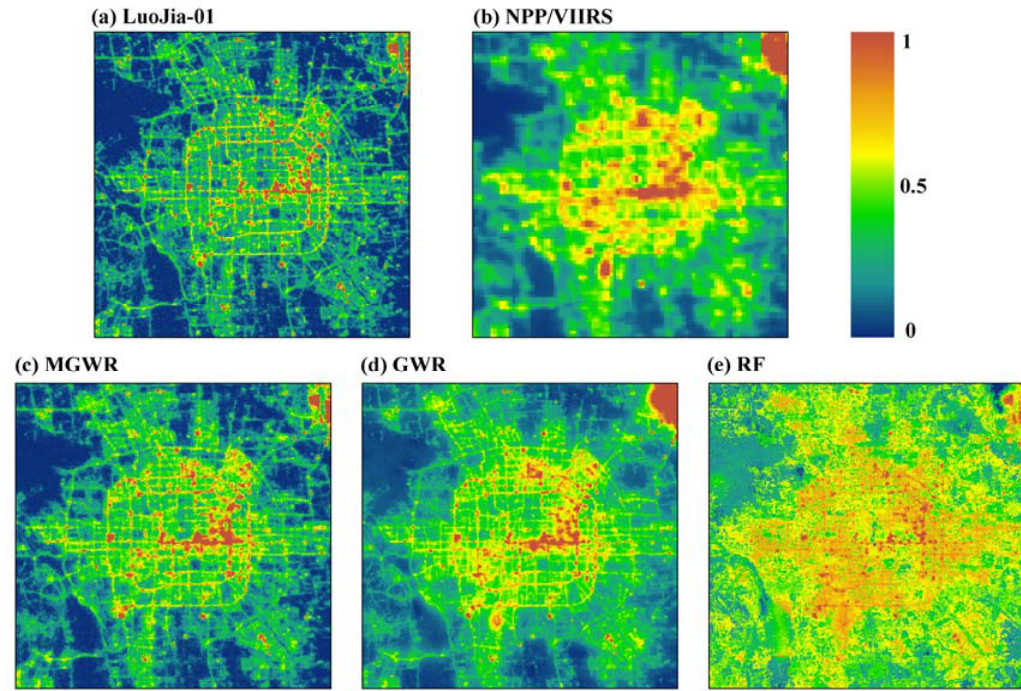
Figure 4. Spatial images showing the comparison of the results of the three downscaling methods in the zoomed-in Beijing city center, ( a ) LuoJia-01, ( b ) NPP/VIIRS, ( c ) MGWR, ( d ) GWR, ( e ) RF. (Spatial resolution: 500 m; study period: September 2018).